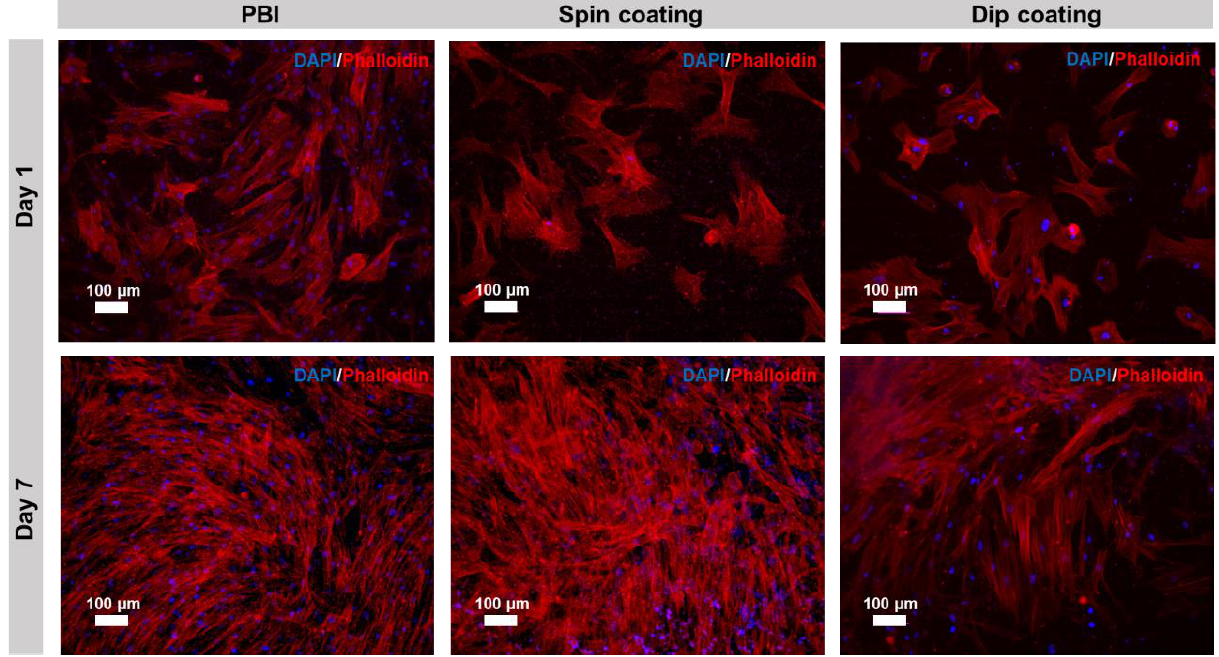
Figure 5. DAPI/Phalloidin immunofluorescence staining of hBM-MSCs cultured on pristine electrospun PBI, PEDOT:PSS- spin coated PBI fibers and PEDOT:PSS-dip coated PBI fibers for days 1 and 7. DAPI stains cell nuclei blue, while Phalloidin stains actin-rich cytoskeleton red. Scale bar: 100 μm.